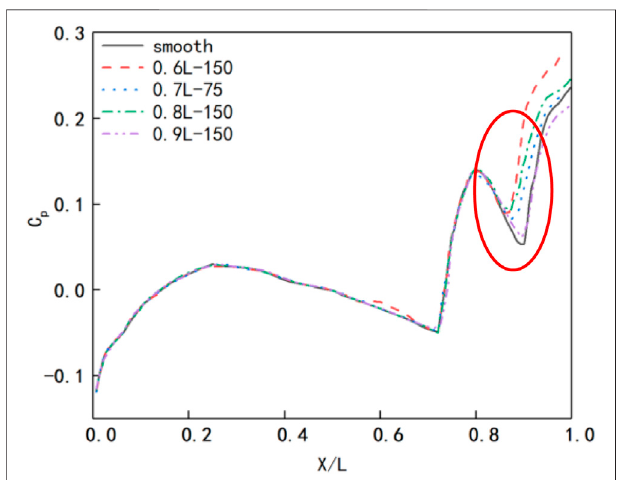
FIGURE 12 | Variation of static pressure loss with roughness